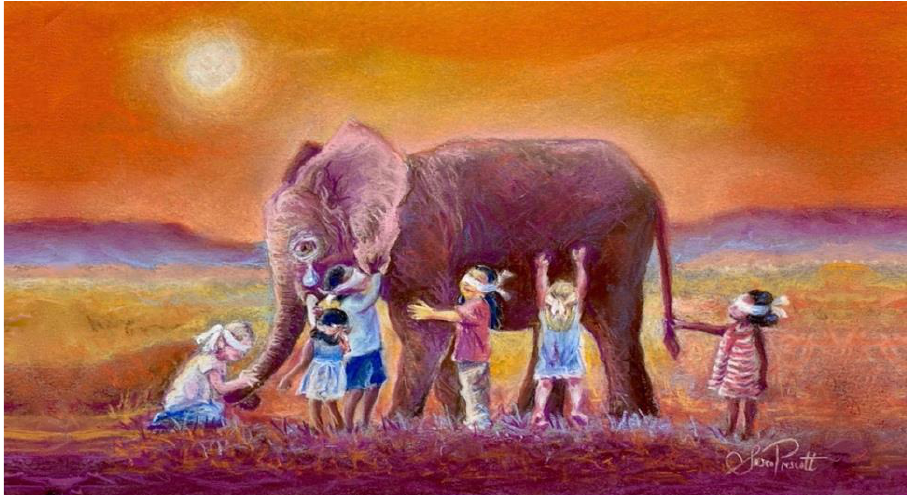
Figure 1. Blinded to the larger perspective: This transcultural parable of separate, isolated, unsighted attempts to describe a mystery speaks to how difficult it is to grasp a whole picture, or a whole system, while engaging with only one of its parts.